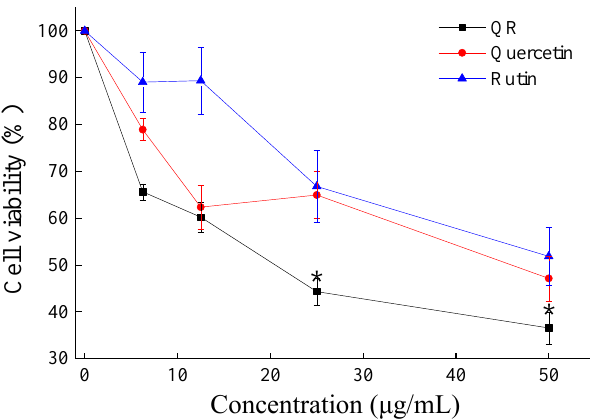
Figure 4. Effect of different concentration complexes on cell viability of MGC80-3. MGC80-3 cells were incubated with samples at indicated concentrations for 24 h, followed by determination of cell viability with MTT. QR (quercetin: rutin = 1:1). Values were expressed as the mean ± SD from experiments in triplicate. One-way ANOVA with LSD was used to determine significant differences within a given treatment. *, p < 0.05 vs. quercetin and rutin.